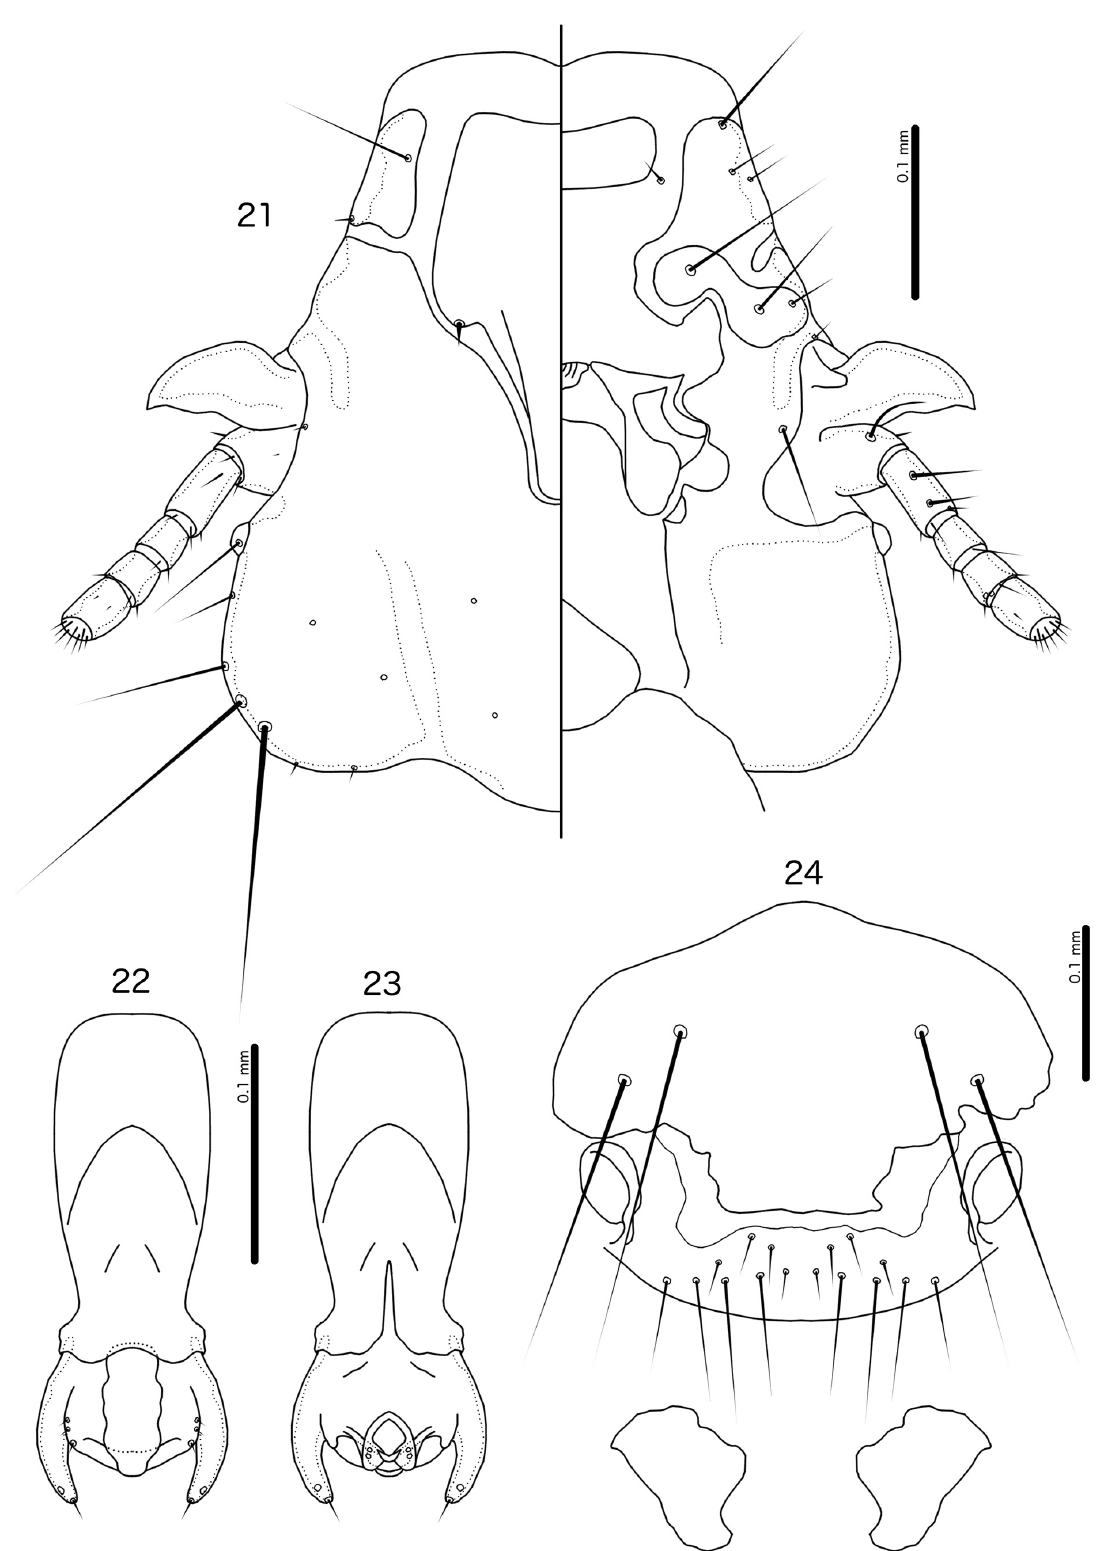
Figs 21–24. Philopterus sinensis sp. nov. ex Hemipus picatus capitalis (Horsfield, 1840). 21 . Male head, dorsal and ventral views. 22 . Male genitalia, dorsal view. 23 . Male genitalia, ventral view. 24 . Female subgenital plate, vulval margin, and subvulval plates, ventral